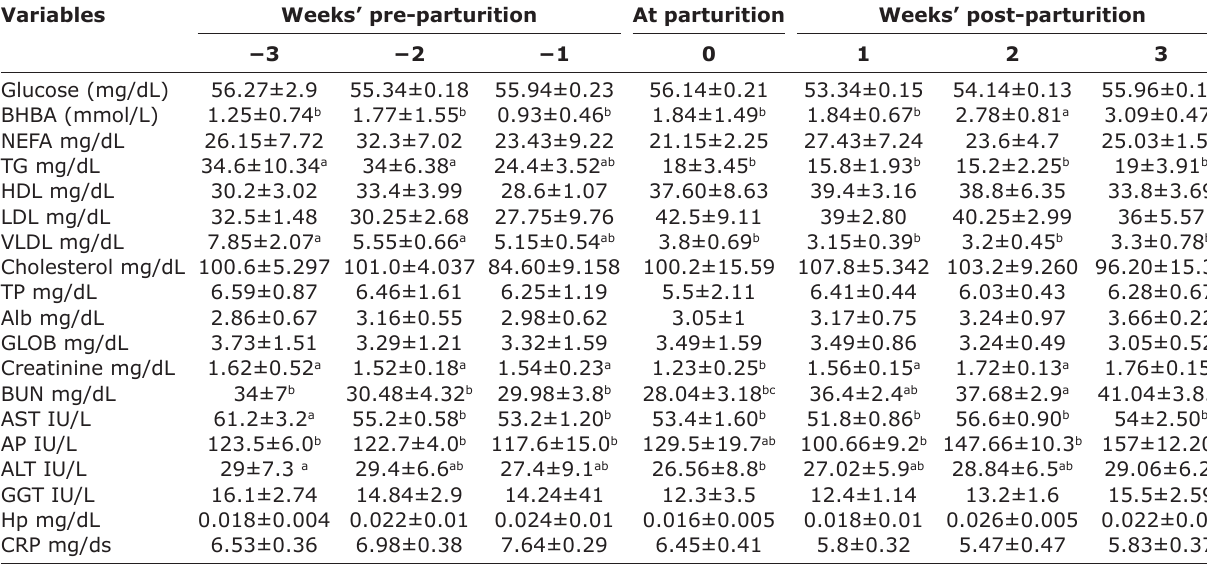
Table-2: Serum biochemical parameters before and after parturition and on the day of parturition at the following time points. Variables Weeks’ pre-parturition